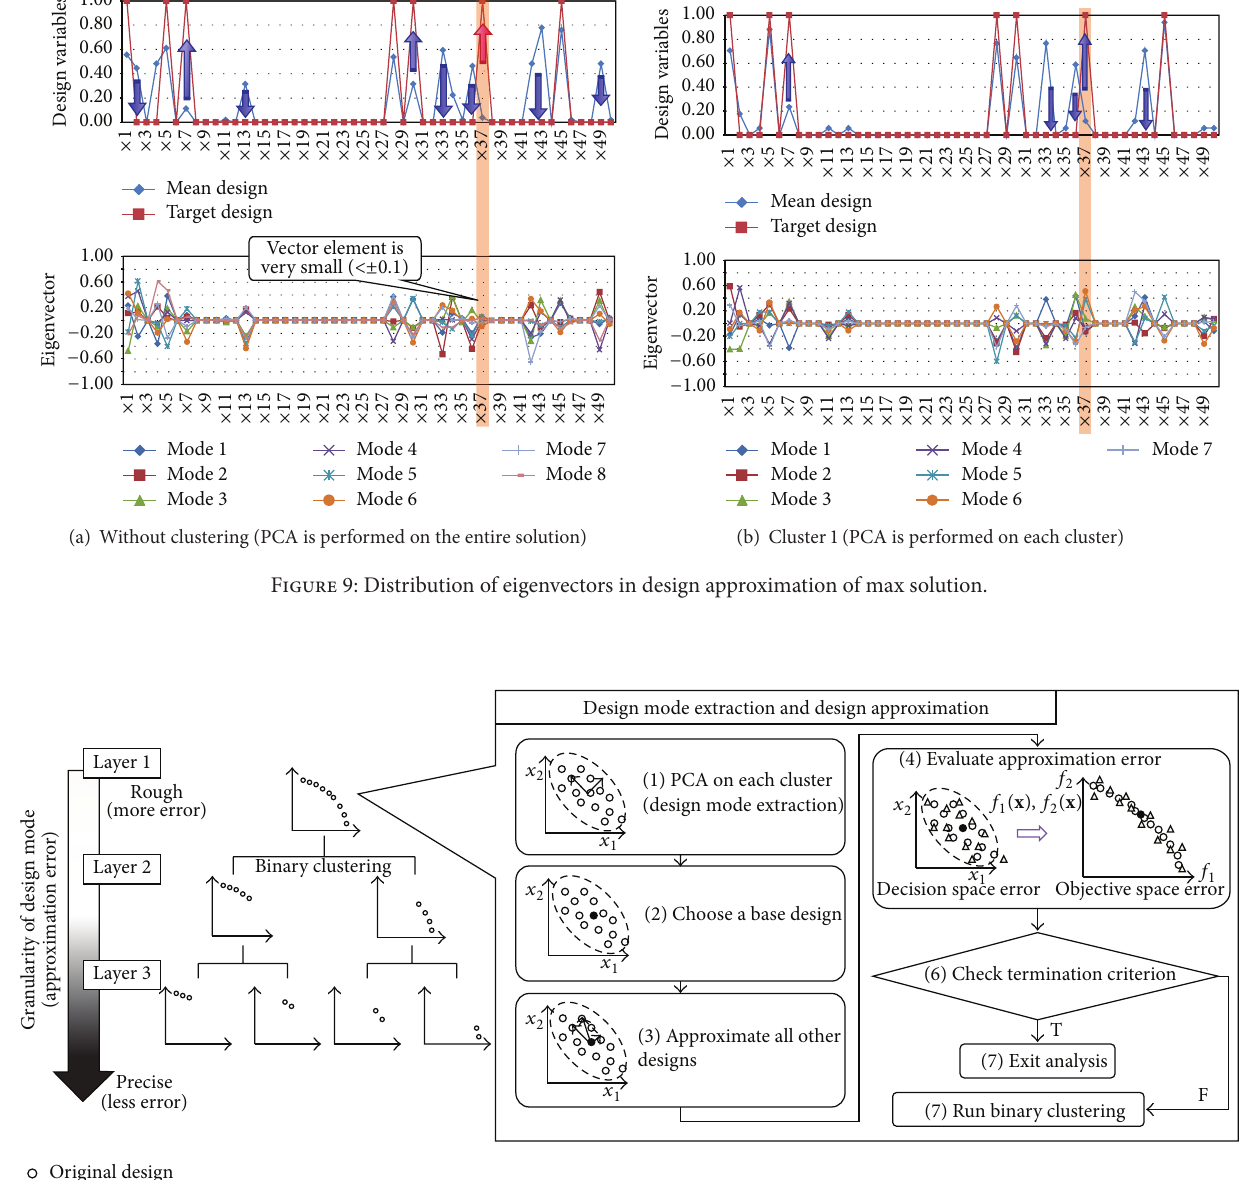
Figure 10: Proposed framework of design mode analysis focusing on